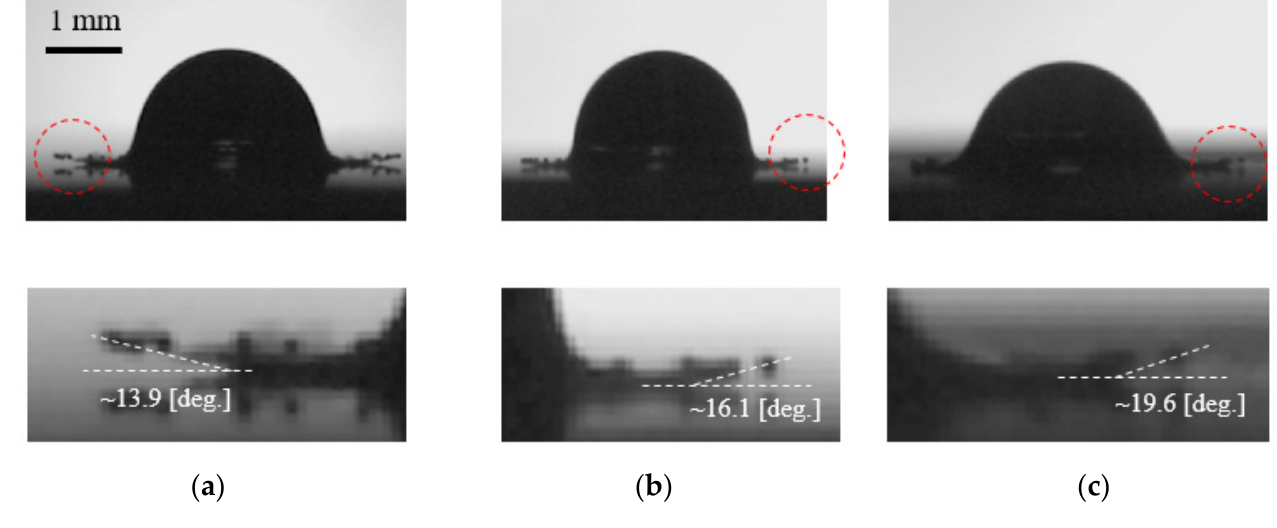
Figure 3. Lifted angle of the liquid film: ( a ) 20 wt% droplet on bare substrate; ( b ) 99.4 wt% on bare substrate; and ( c ) 99.4 wt% on #240 substrate.